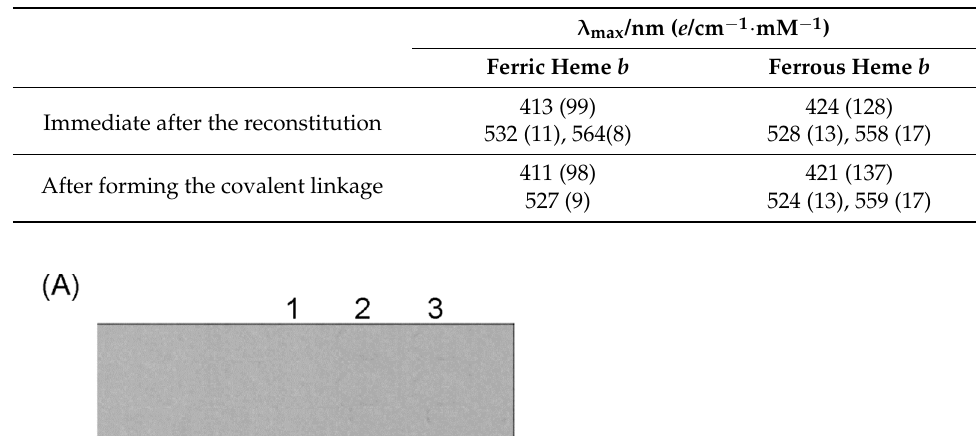
Table 1. Absorption maxima of C14A reconstituted with ferric and ferrous heme b recorded immedi- ately after the reconstitution and after the covalent linkage formation.